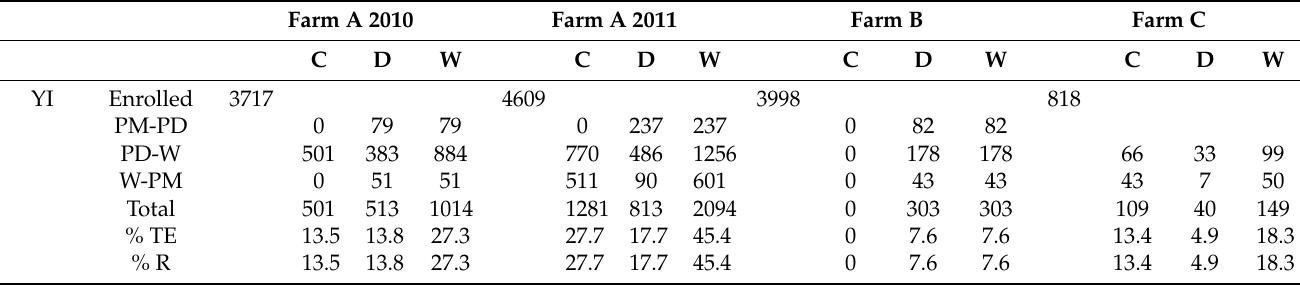
Table A2. Number of ewes that were recorded as prematurely culled (C) or dead/missing (D) and overall wastage (W),